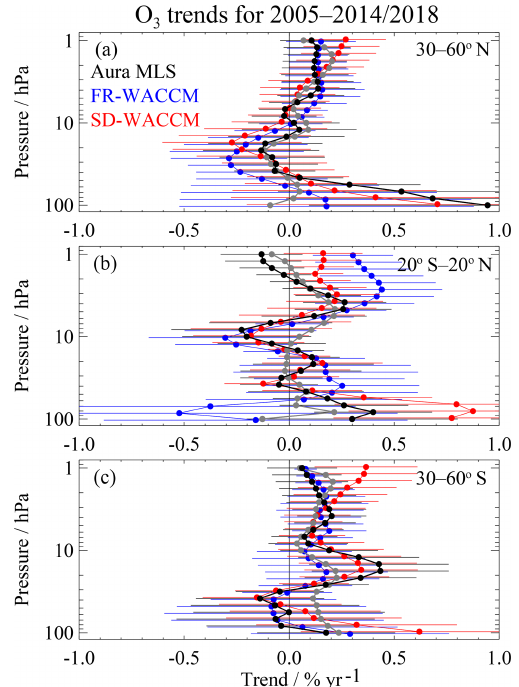
Figure 19. Ozone stratospheric trends for 2005 through 2014 ob- tained from monthly zonal mean data (version 4.2 Aura MLS) and models (FR-WACCM and SD-WACCM), after multiple linear re- gression analyses of deseasonalized anomaly time series, as de- scribed in the text. Each panel refers to results from different lat- itude band average series (see legend). The error bars are 2 σ es- timates based on bootstrap resampling results (see text). We also show the data trends for 2005–2018 (in grey) to provide an update on how the past 4 years change the (slightly longer-term) tenden- cies; to avoid more clutter in these plots, we have not overplotted the corresponding error bars, but these are only slightly smaller than the black observational error